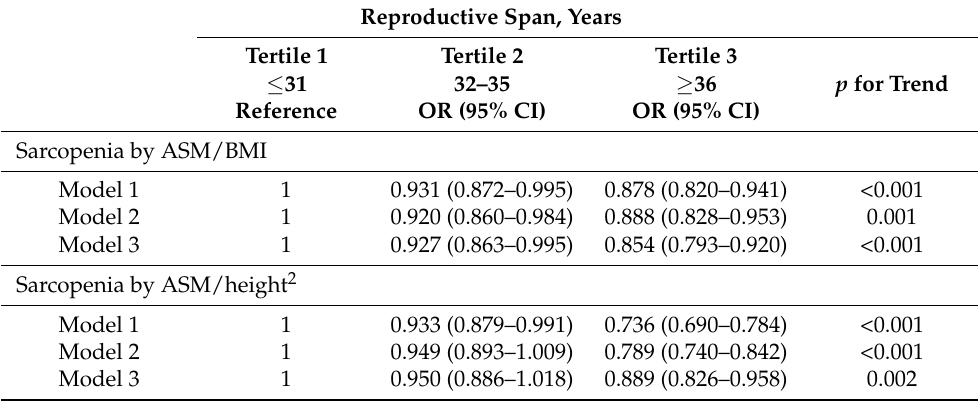
Table 3. Multivariate logistic regression analysis of the relation between reproductive span and